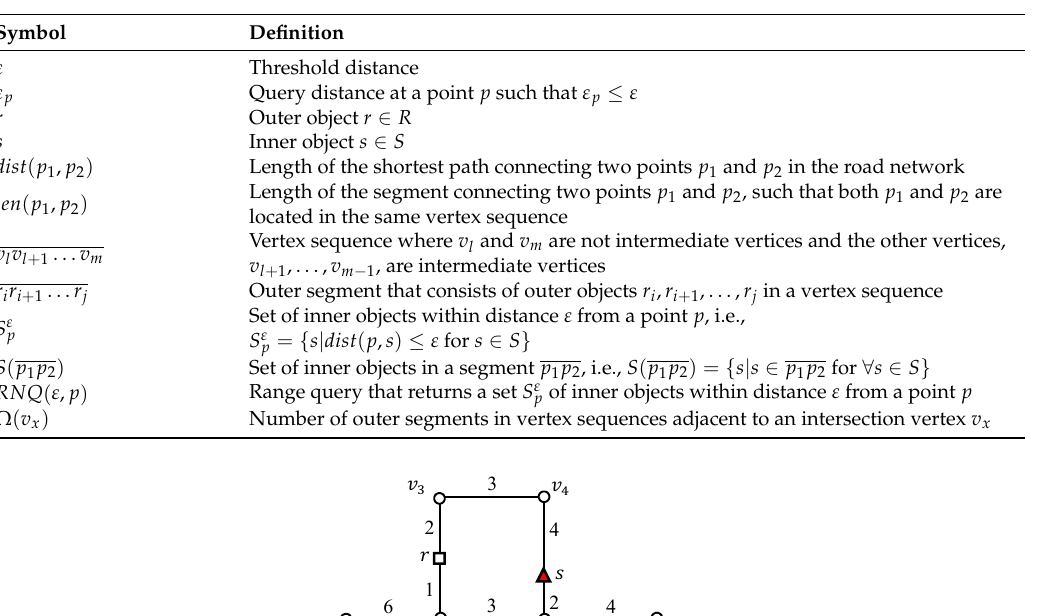
Table 1. Symbols and their meaning.